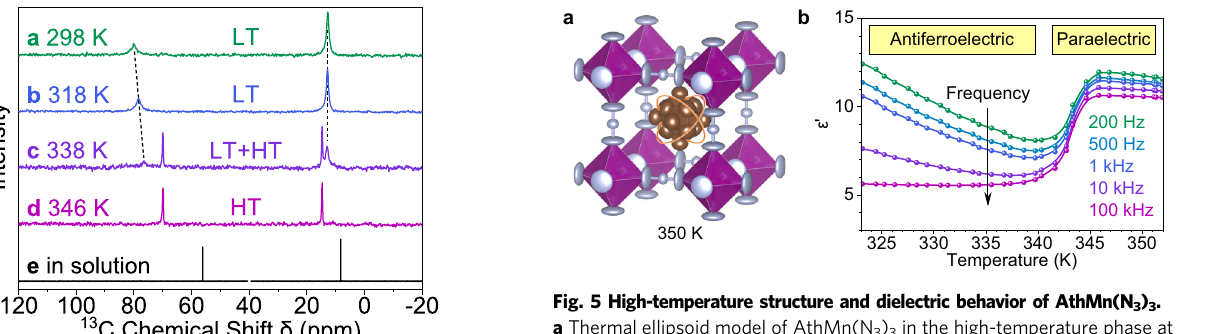
Fig. 5a, the orientation of Ath + becomes disordered, the azido N − are uniformly distributed at the 6f position of the unit cell, and the preferred orientation for hydrogen bonding no longer exists.